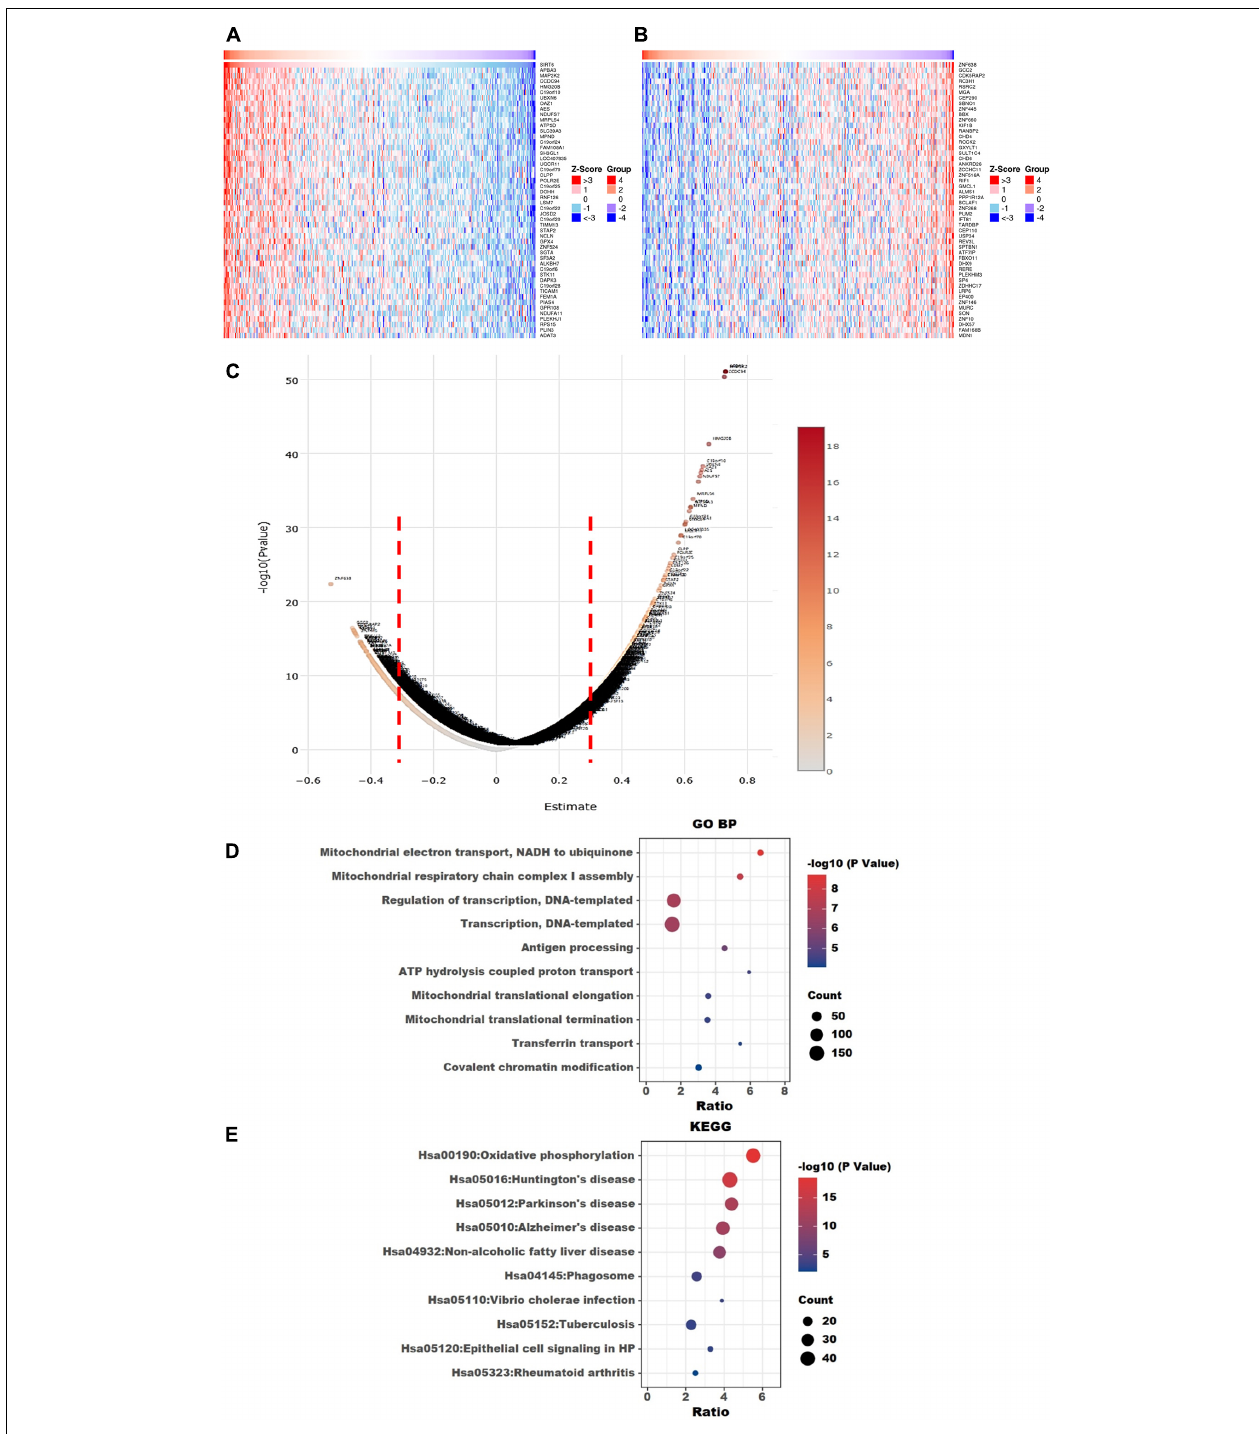
FIGURE 9 | Visualization of Gene Ontology (GO) and Kyoto Encyclopedia of Genes and Genomes (KEGG) enrichment analyses for SIRT6 correlated genes from The Cancer Genome Atlas ovarian cancer (TCGA-OV). (A) Heatmap of the top 50 positively correlated genes of SIRT6 from TCGA-OV after normalization. (B) Heatmap of the top 50 negatively correlated genes of SIRT6 from TCGA-OV after normalization. Red indicates cases with higher expression and blue indicates cases with lower expression ( Z -score). (C) Volcano plot of all correlated genes of SIRT6 in TCGA-OV, as determined using Pearson’s correlation test. X -axis is the correlation coefficient. Red dotted line indicates the cutoff value for GO and KEGG analyses. (D) Top 10 terms of GP BP (biological process) enrichment analysis of the selected genes with Pearson’s correlation > | 0.3| for SIRT6. (E) KEGG enrichment analysis using genes as per Pearson’s correlation test. The p -value was calculated and sorted with − log 10 ( P ). Dark red indicates the lowest p